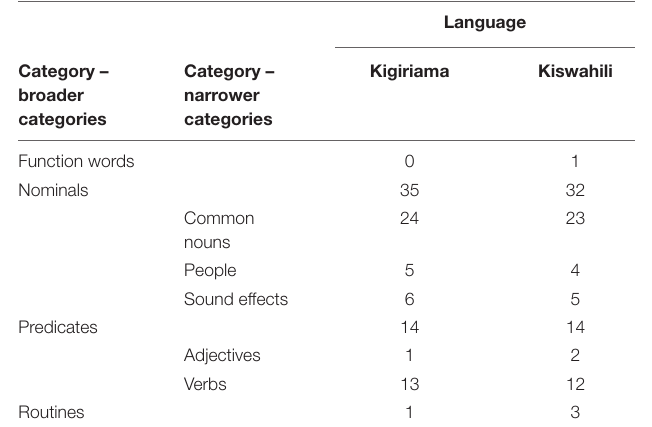
TABLE 3 | Highest ranked 50 words in each language, categorized by word class – Count of words for Comprehension.